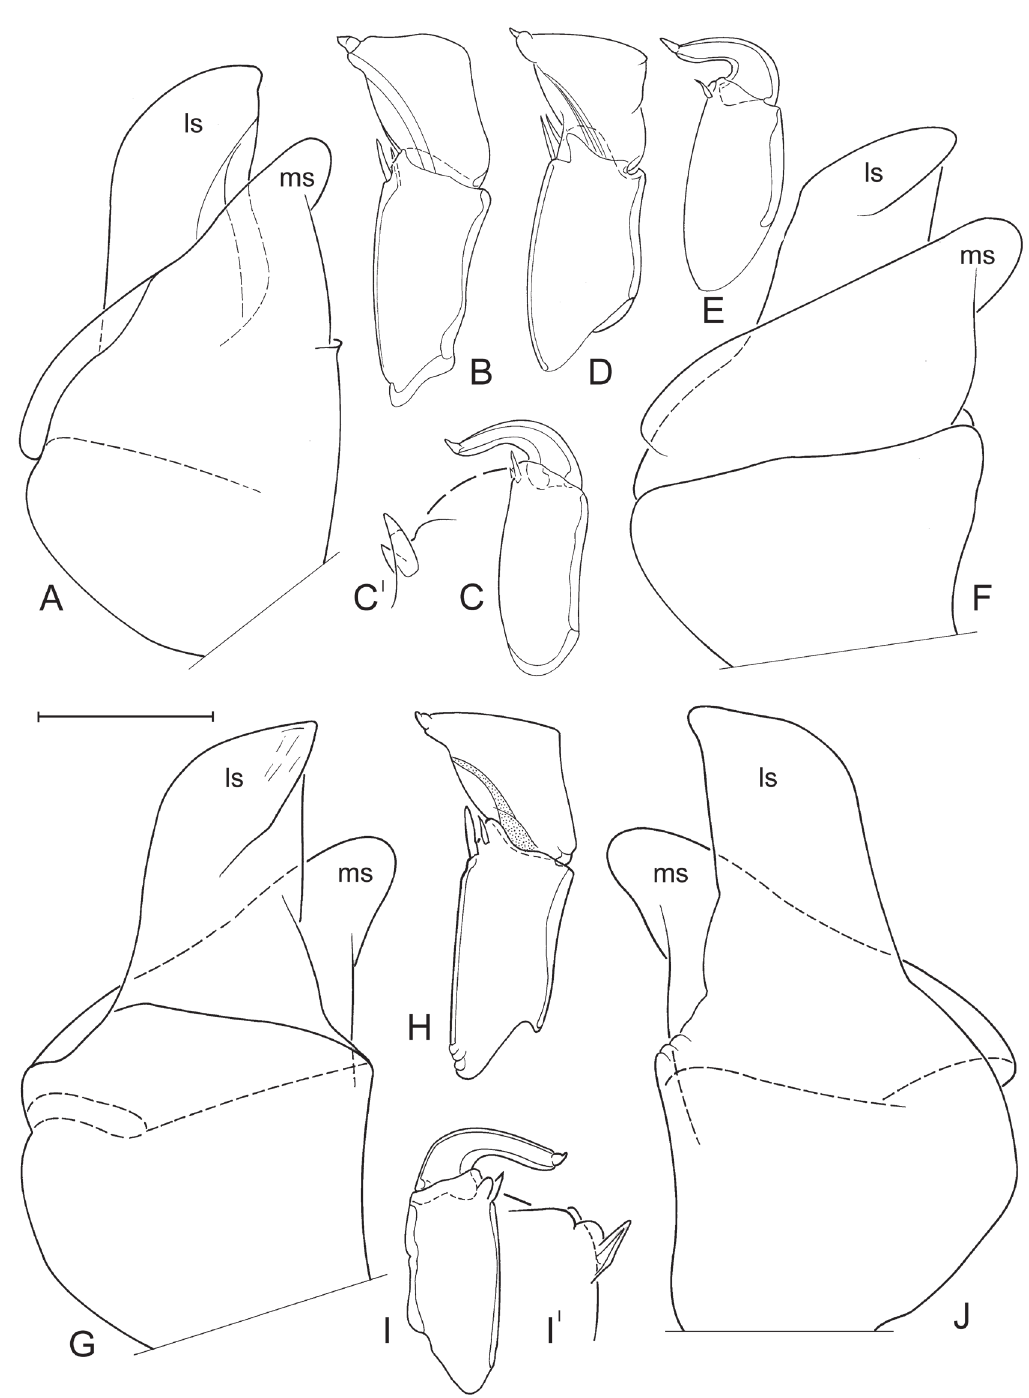
Fig. 20. Bennelongia scanloni sp. nov., males. — A-C’ . non-type (Oc.3338, three springs tumulus stream - tst): A . Hemipenis (both hemipenes symmetrical in this specimen). B . right prehensile palp. C . left prehensile palp. C’ . Idem, detail of ventro-apical part of first segment. — D-F . Holotype (WaMc52291, One tree Hill creek – DJc/11): D . right prehensile palp. E . left prehensile palp. F . Hemipenis (both hemipenes symmetrical in this specimen). — G-J . non-type (WaMc52327, from Ostr013c): G . Hemipenis. H . right prehensile palp. I . left prehensile palp. I’ . Idem, detail of ventro- apical part of first segment. J . Hemipenis. scale: a-J = 92 µm; c’, I’ = 37